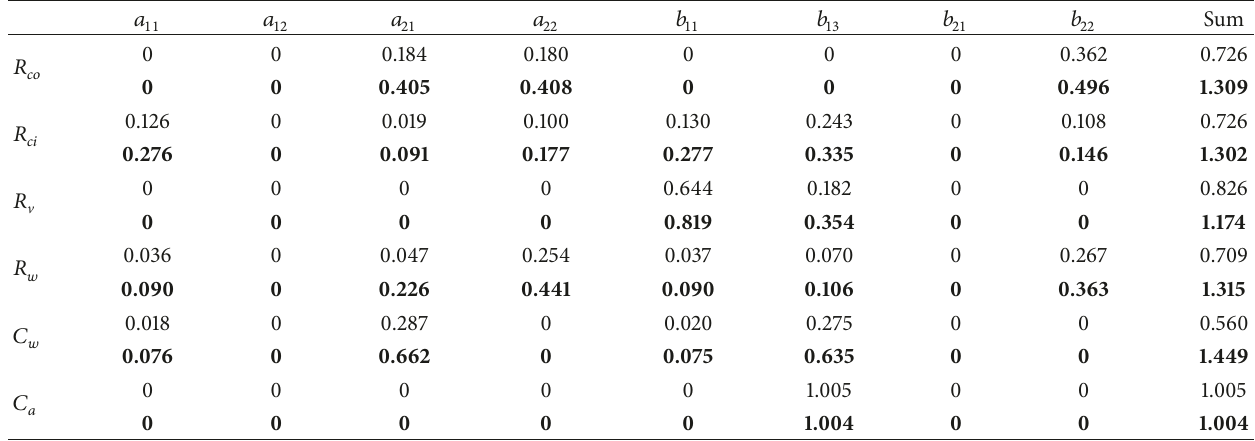
Table 10: First-order and total sensitivity indices, SS to RC transformation.